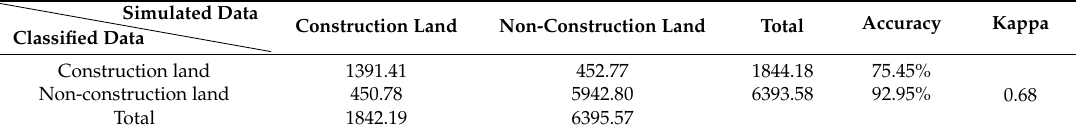
Table 8. Kappa coe ffi cient of construction land in 2013 (unit: km 2 ).